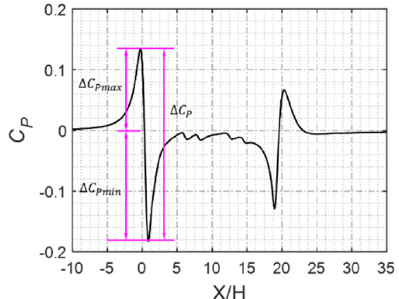
Figure 12. Definition of maximum pressure coefficient ( Δ Cp max), the absolute value of minimum pressure coefficient ( Δ Cp min), and pressure change coefficient ( Δ Cp ).